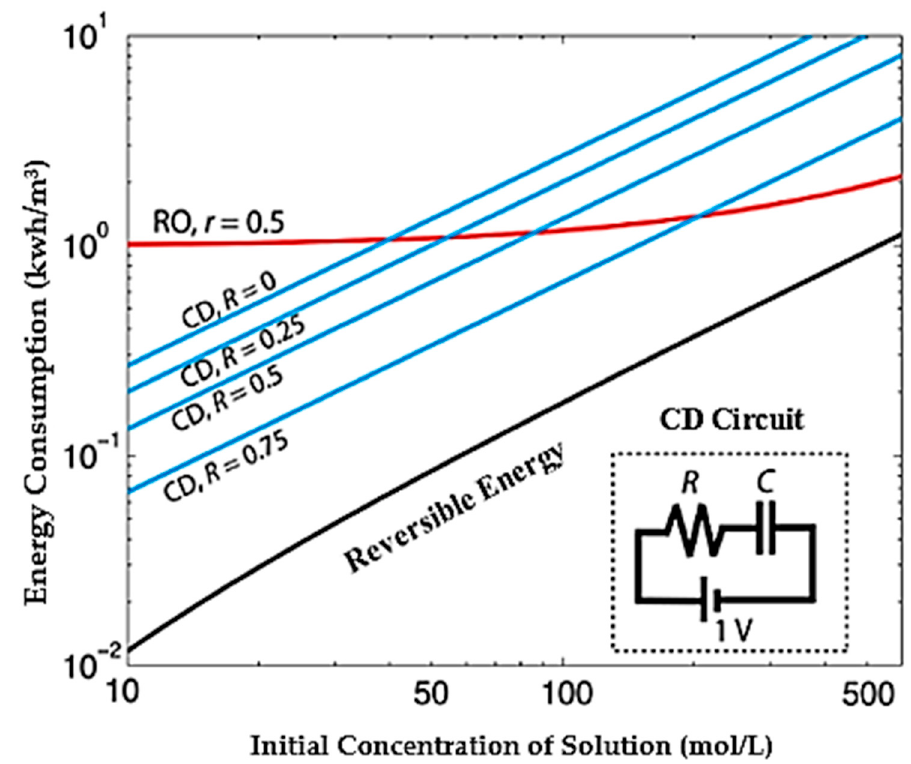
Figure 2. Estimation of energy consumption for reverse osmosis desalination and capacitive deion- ization method. Reprinted/adapted with permission from Ref. [25]. 2013, Suss, M.